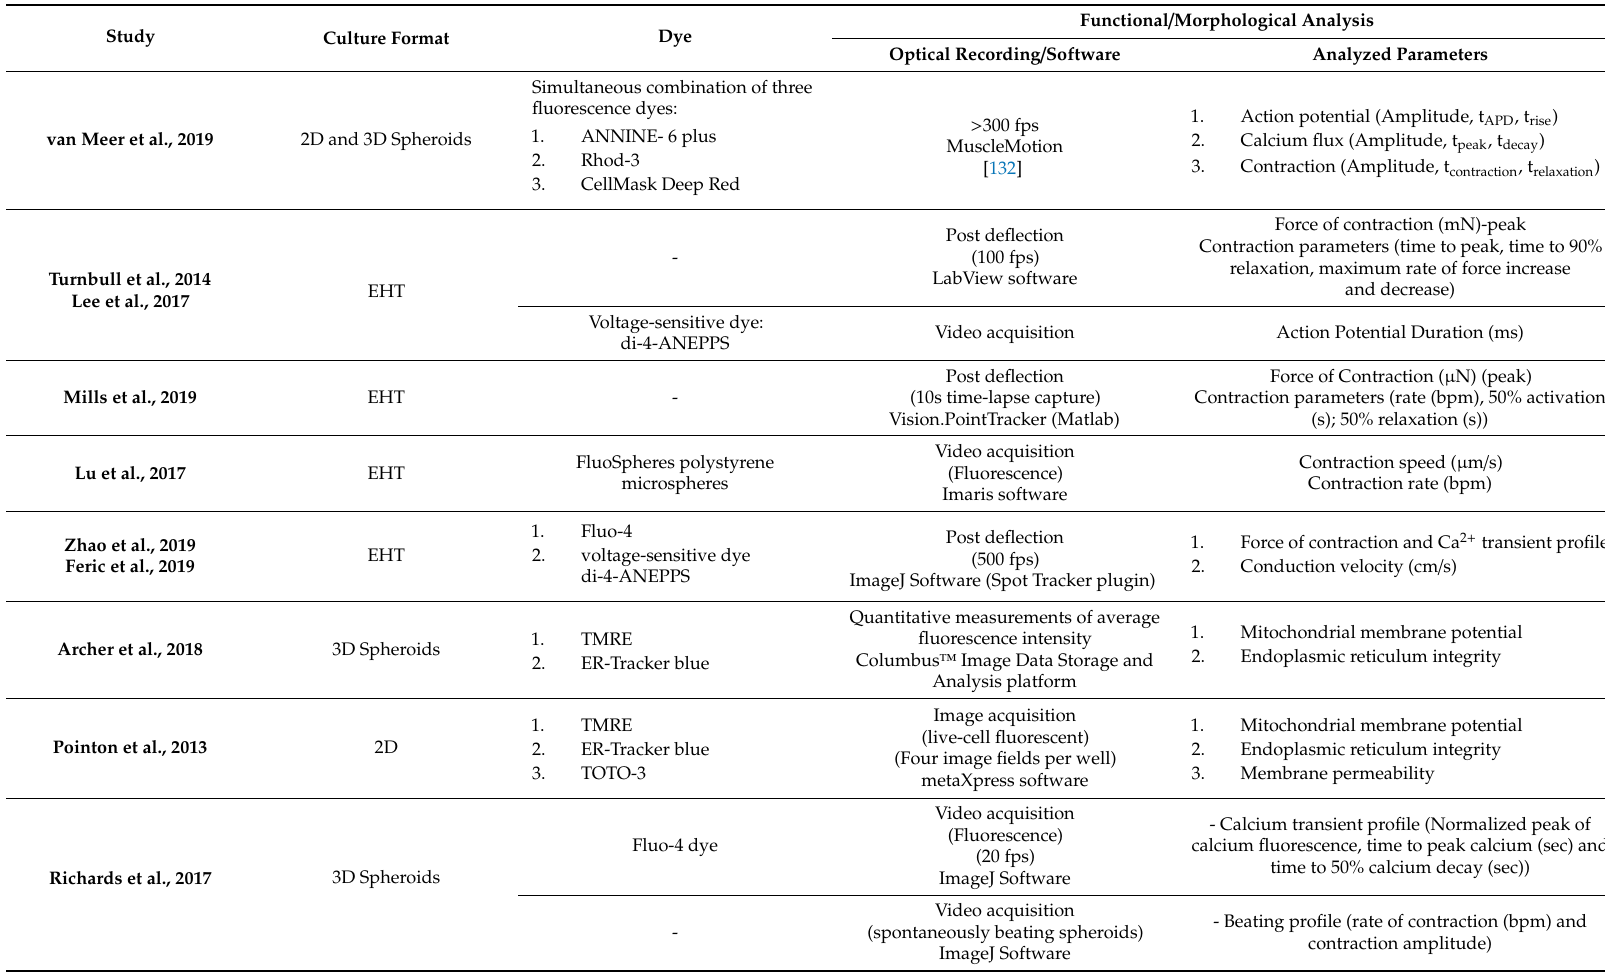
Table 4. Summary of the main experimental setups used to assess functional and morphological parameters in 2D cultured hPSC-CMs, 3D cardiac MTs and EHT models. fps, frames per second; bpm, beats per